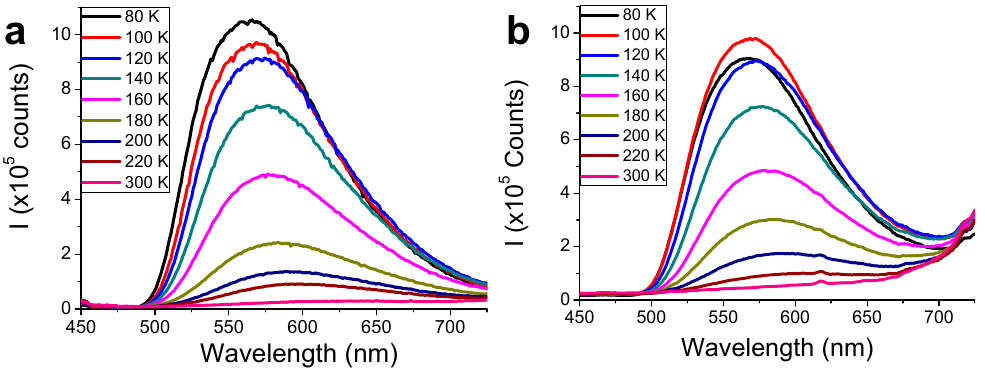
Figure 6. Thermal dependence of the luminescence spectra of [Cu 2 I 2 (Apyz)] n ( a ) and the [Cu 2 I 2 (Apyz)] n @PLA thin film with 30% w / w of [Cu 2 I 2 (Apyz)] n ( b ).